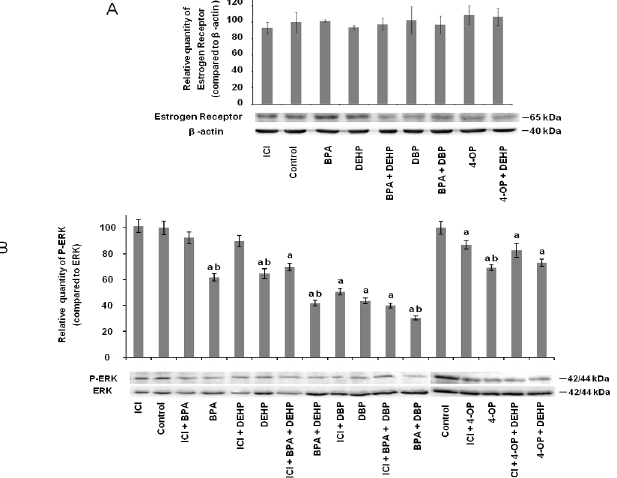
Fig 5. Effect of EDCs alone and in combination on estrogen receptor protein expression and signaling. (A) Differentiated THP-1 cells (PMA 5 ng/ml for 48 hours) were exposed to ICI-182780 (1 μ M), BPA, DEHP, BPA + DEHP, DBP, BPA + DBP, 4-OP or 4-OP + DEHP (each EDC at 0.1 μ M) for 24 hours. Culture medium was replaced by fresh medium containing 10 ng/mL of LPS for a subsequent 24 hours of incubation. Whole cell lysates (20 μ g) were separated by SDS-PAGE (10%) and immunoblotted with the anti- estrogen receptor antibody as described in Materials and Methods. The same blot was stripped and immunoblotted with control antibody (anti- β -actin). Histograms represent the relative quantifications of ER α which were performed in comparison with β -actin. Values in non-treated cells are taken as 100%. Each experiment has been performed four times. Values are means ± SD (N = 4). a: vs control (One-way ANOVA, Tukey post test, p < 0.05). (B) Differentiated THP-1 cells (PMA 5 ng/ml for 48 hours) were exposed to ICI- 182780 alone and in combination with BPA, DEHP, BPA + DEHP, DBP, BPA + DBP, 4-OP, 4-OP + DEHP for 24 hours. Culture medium was replaced by fresh medium containing 10 ng/mL of LPS for a subsequent 24 hours of incubation. Each EDC was also tested without ICI. EDCs and ICI were used at 0.1 μ M and 1 μ M respectively throughout this experiment. Whole cell lysates (20 μ g) were separated by SDS-PAGE (10%) and immunoblotted with the anti-phospho-ERK antibody as described in Materials and Methods. The same blot was stripped and immunoblotted with anti-ERK antibody. Histograms represent the relative quantifications of phospho-ERK which were performed in comparison with ERK. Values in non-treated cells are taken as 100%. Each experiment has been performed three times. Values are means ± SD (N = 3). a: vs control (One- way ANOVA, Tukey post test, p < 0.05); b: vs exposure to corresponding EDCs after treatment by ICI (One- way ANOVA, Tukey post test, p <